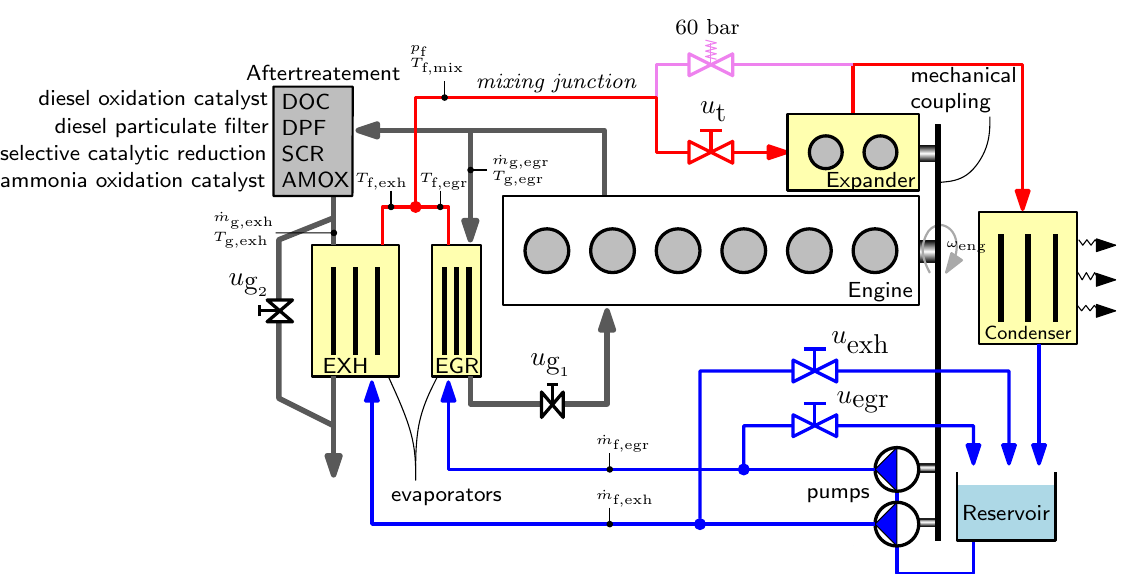
Figure 1. Schematic representation of the experimental